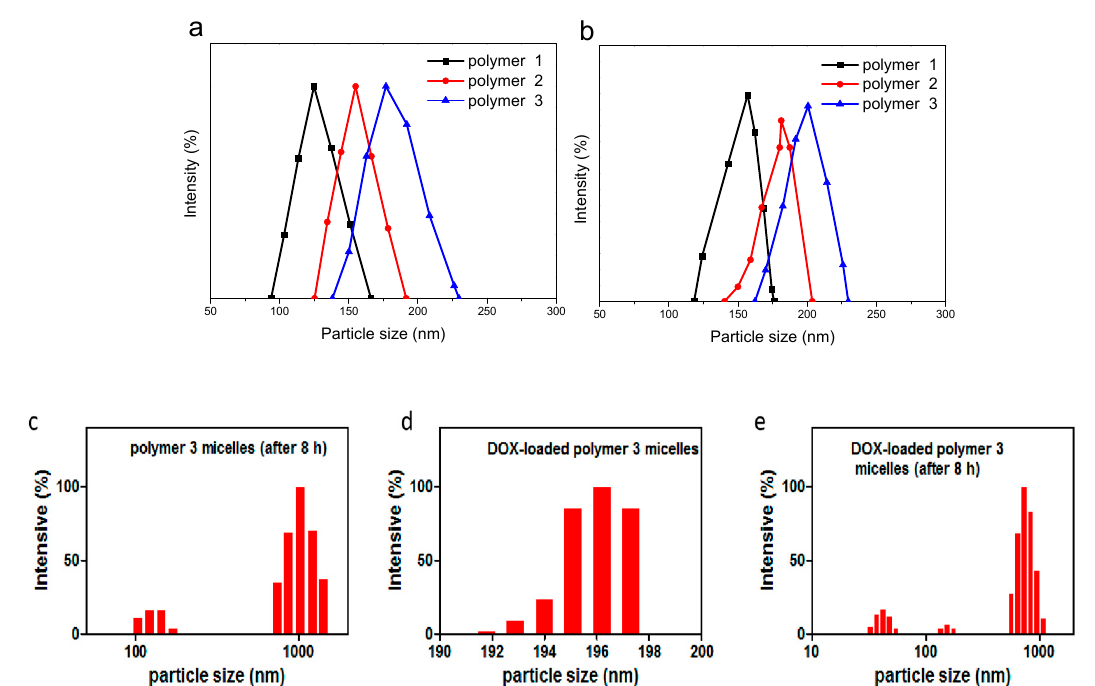
Figure 4. Particle size distributions of micelles of the three polymers in PBS for ( a ) 0 h and ( b ) 8 h; ( c ) polymer 3 micelles’ response to 10 mM DTT in PBS for 8 h, ( d ) Dox-loaded polymer 3 micelles; and ( e ) drug-loaded polymer 3 micelles’ response to 10 mM DTT in PBS for 8 h.